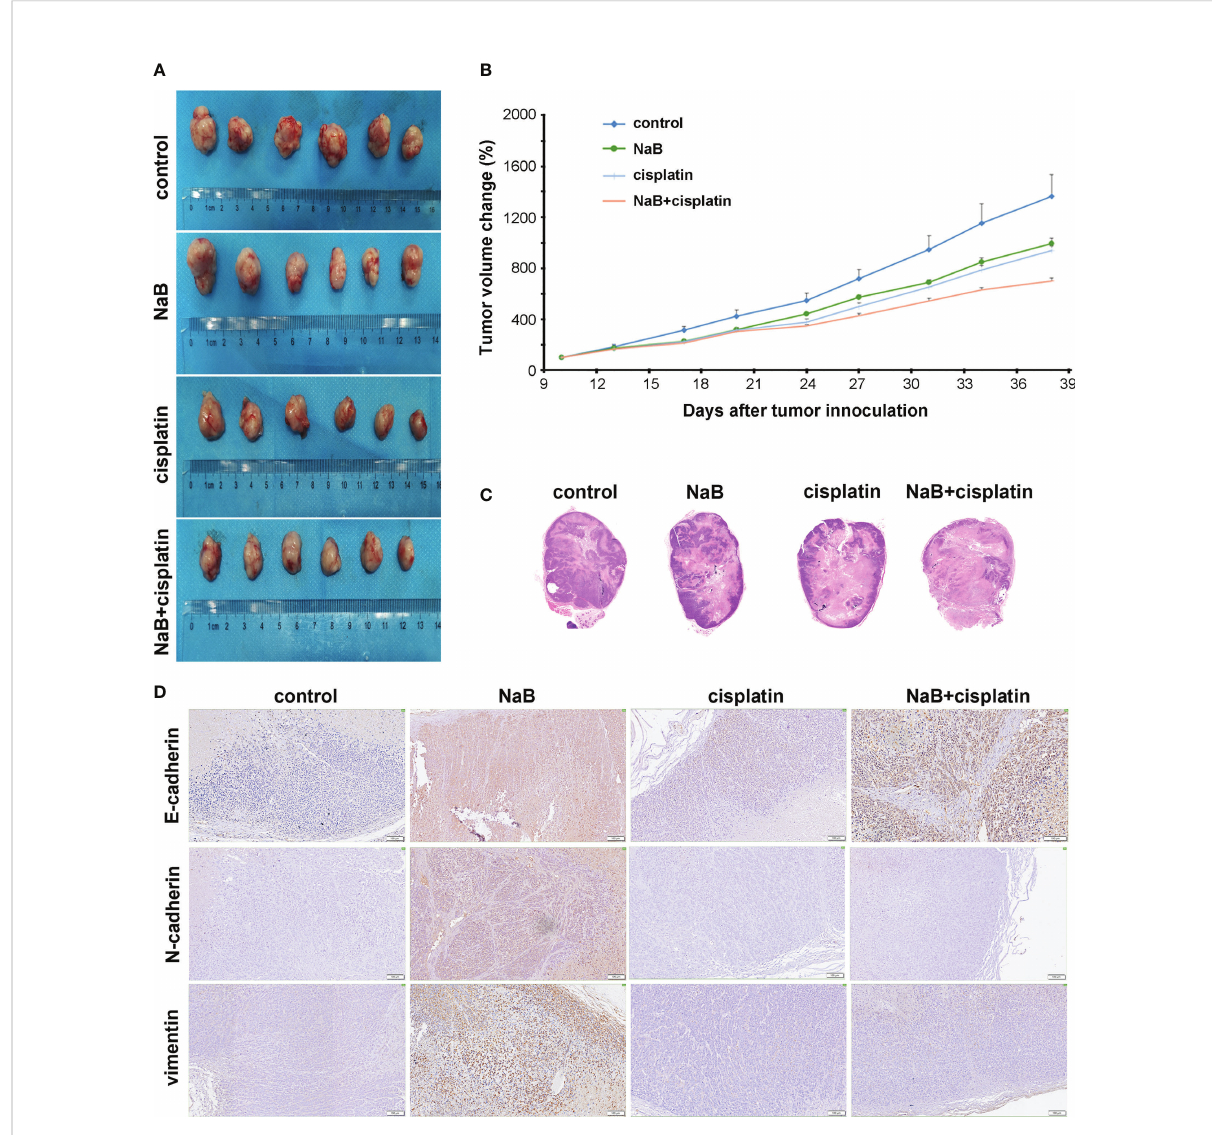
FIGURE 3 In vivo effects of NaB alone or in combination with cisplatin on cervical cancer. (A, B) The tumor volume of the mouse xenografts. (C) Representative H&E staining of subcutaneous xenografts (Magni fi cation: 200 ×). (D) Immunohistochemical staining of E-cadherin, N-cadherin, and vimentin in tumor tissues collected from mouse models of cervical cancer 4 weeks after the treatment. Bars: 100 m m. The mice were treated with NaB alone (200 mg/kg/ day) or in combination with cisplatin (5 mg/kg/week). NaB, sodium